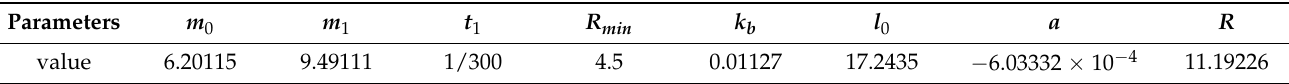
Table 6. Parameters of constraint method.